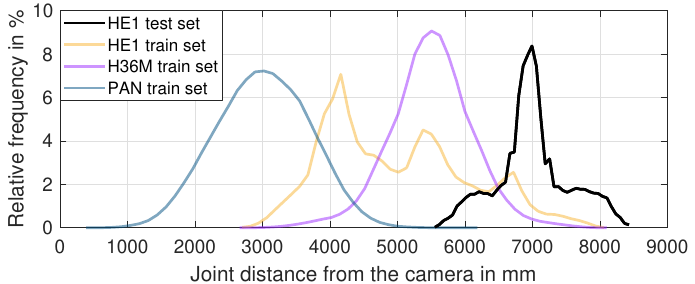
Figure 6. Relative distribution of all joint-to-camera distances for the HE1 test set and all training sets (full camera set).